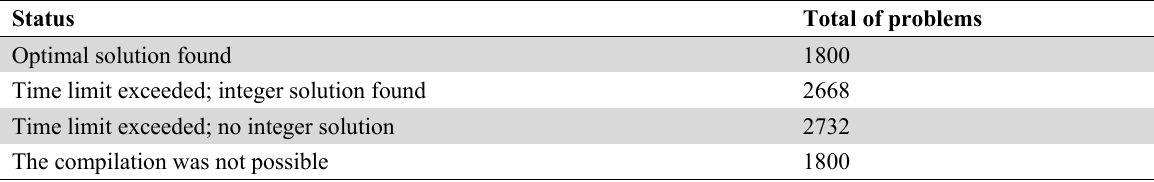
Results of 𝑴𝑰𝑷 within 1 hour of processing time 𝑻𝑻𝑵